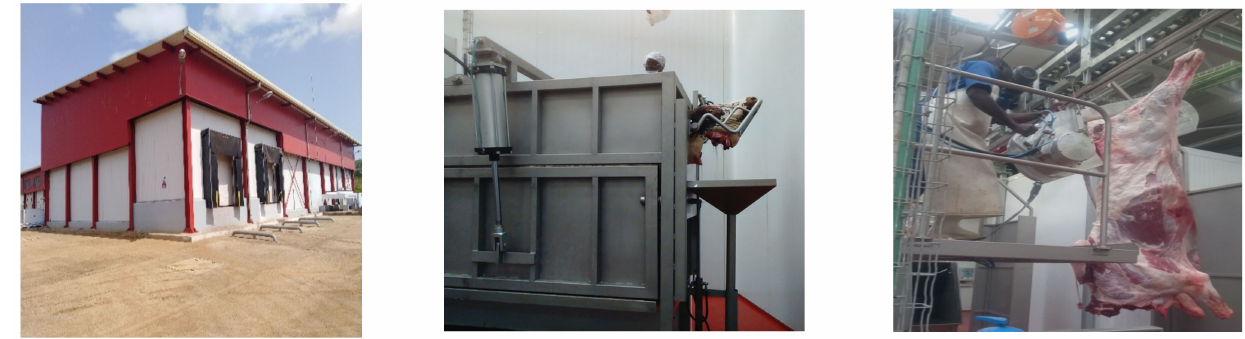
Figure 4. Modern slaughterhouse, slaughter and carcass processing in Ngaound é r é .